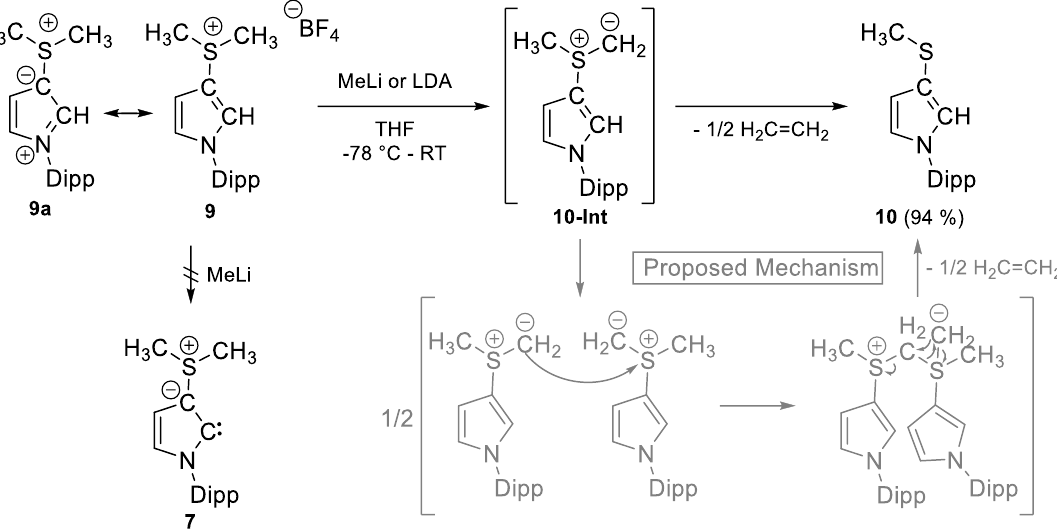
Figure 3. Molecular structure of N -(2,6-diisopropylphenyl)pyrrole (left) and 9 . Ellipsoids are drawn at the 50% probability level. Selected bond lengths (Å ) and angles (°): N-(1,2- Diisopropylphenyl)pyrrole: N1–C1 1.374(2), N1–C4 1.375(2), C1–C2 1.370(2), C2–C3 1.416(3), C3–C4 1.367(2). 9 : S2–C2 1.748(1), N1–C1 1.362(1), C1–C2 1.376(2), C2–C3 1.412(2). Comparison of the structure of the sulfonium salt 9 with that of the pyrrole precursor N -(2,6- diisopropylphenyl)pyrrole revealed similar structural changes upon introduction of the onium moiety, as previously observed by Fürstner and coworkers. [26] As a result of the delocalization of the charge of the sulfonium moiety into the pyrrole ring of 9 and the thus more pronounced contribution of the ylidic resonance structure 9b to the overall electronic structure of 9 , the C1–C2 bond in 9 (1.376(2) Å ) was elongated compared the one found in N -(2,6-diisopropylphenyl)pyrrole (1.370(3) and 1.367(2) Å ). Likewise, the C1–N1 bond shortened from approx. 1.374 Å in the unsubstituted pyrrole to 1.362(1) Å in 9 . Since deprotonation of 9 at the methyl group was clearly kinetically favored over the desired carbene formation, we next turned our attention towards a tricyclohexyl phosphonium salt. We envisioned that the cyclohexyl group should be less prone to ylide formation (due to electronic and steric reasons) and thus allow for the formation of carbene 8 . The phosphonium precursor 11